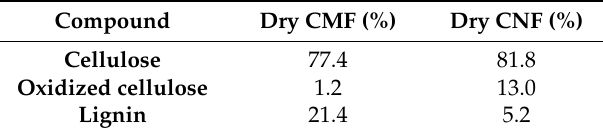
Table 4. Dry CMF and CNF composition.